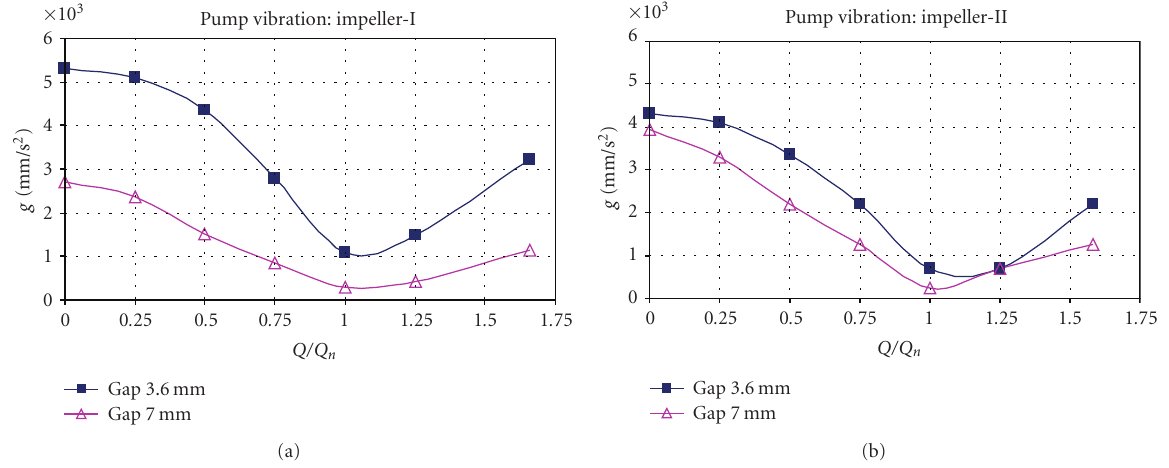
Figure 11: E ff ect of doubling the radial gap on vibration of pump